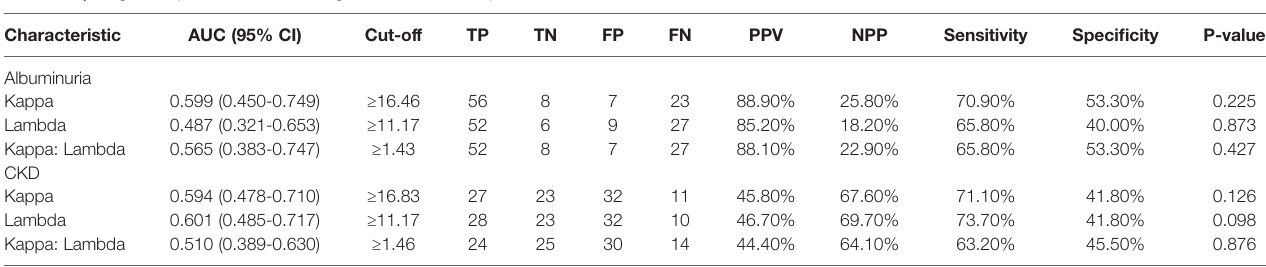
TABLE 3 | Diagnostic performance of free light chains to detect patients with DN.